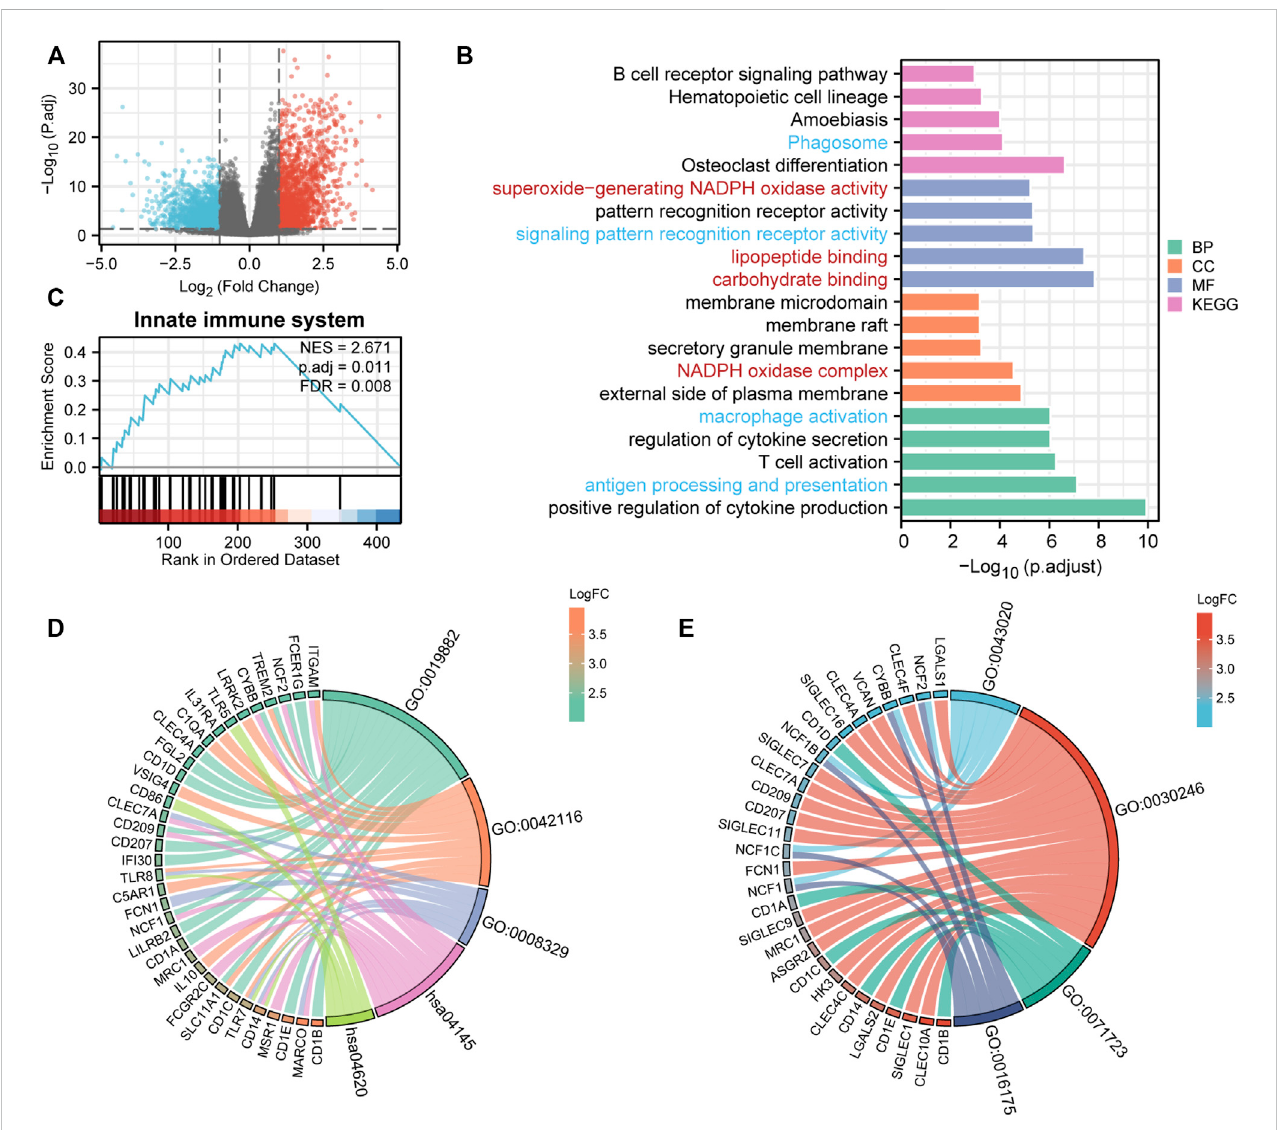
FIGURE 3 DEG analysis and Functional enrichment analyses of DEGs. (A) Volcano plot of DEGs. (B) GO and KEGG pathway of up-regulated DEGs. Red context represents innate-immune signaling sets and blue means metabolic-related pathway sets. (C) Enriched in innate immune system by GSEA analysis. immune system. (D – E) Interactive analysis of enriched pathways in GO/KEGG and corresponding genes. (D) Innate-immune signaling sets and the corresponding genes. GO:0019882, antigen processing and presentation; GO:0042116, macrophage activation; GO:0008329, signaling pattern recognition receptor activity; hsa04145, Phagosome; hsa04620, Toll-like receptor signaling pathway. (E) Metabolic-related signaling sets and the corresponding genes. GO: 0043020, NADPH oxidase complex; GO:0030246, carbohydrate binding; GO:0071723, lipopeptide binding; GO:0016175, superoxide-generating NADPH oxidase